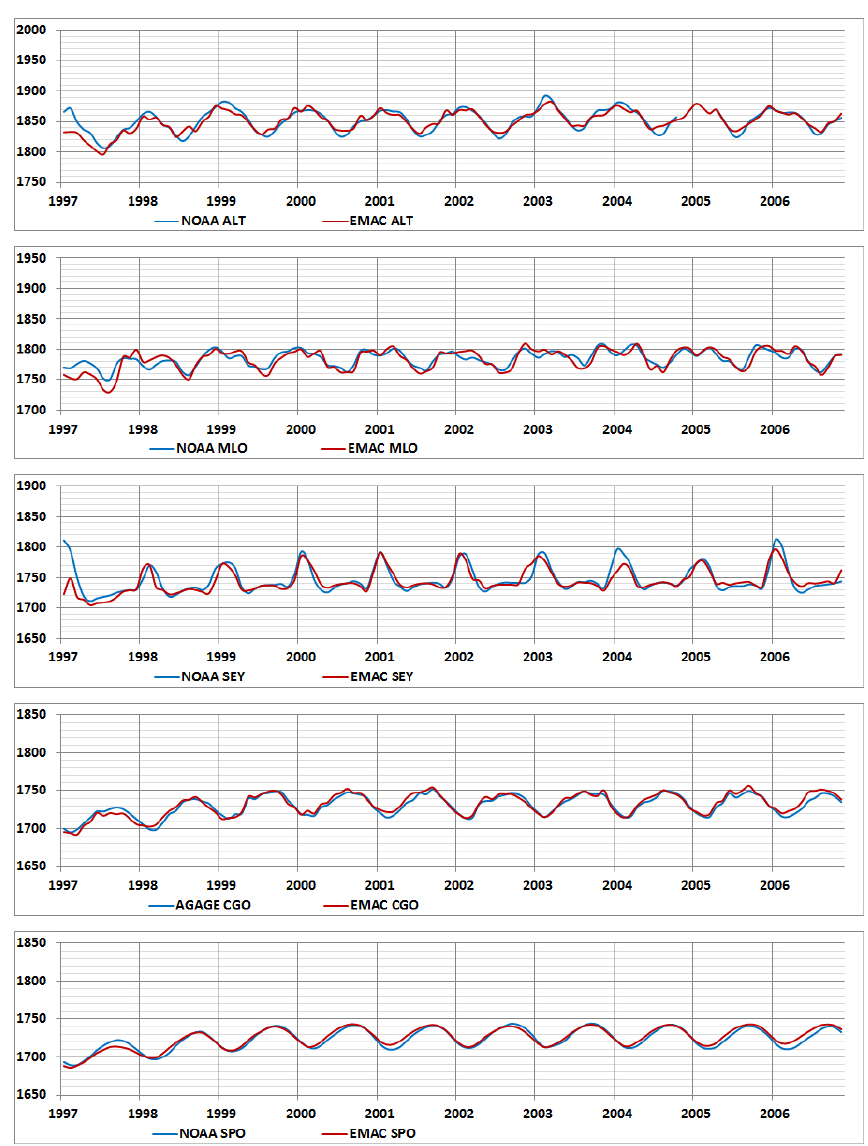
Figure 5. EMAC calculations (red) vs. NOAA and AGAGE observations (blue) of CH 4 from 1997 to 2006.